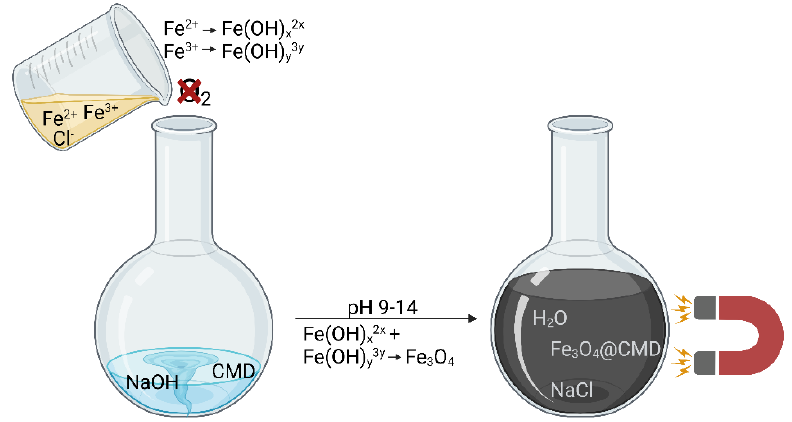
Figure 1. Schematic illustration of ION@CMD synthesis by the in situ co-precipitation technique according to Massart. It was created with